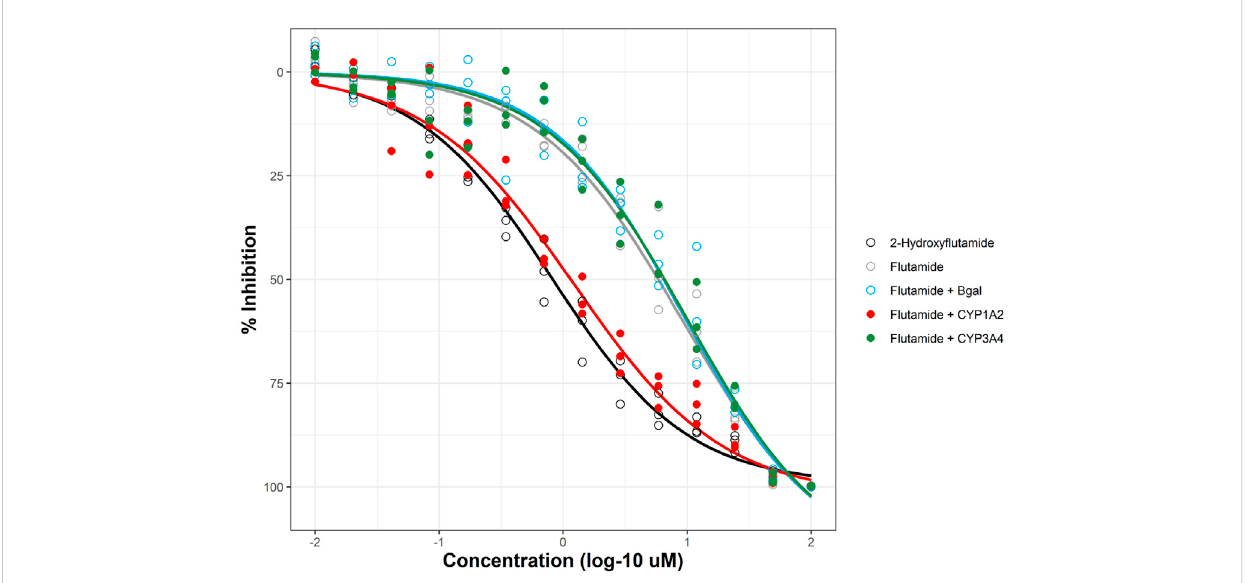
FIGURE 5 Metabolic retro fi t of AR2 assay. AR2 cells were transfected with mRNAs encoding beta-galactosidase (Bgal, blue), human CYP1A2 (red), CYP3A4 (green), or no RNA (black and grey) 6 h prior to co-treatment with 10 nM R1881 and either fl utamide or its anti-androgenic metabolite, 2- hydroxy fl utamide (black) at concentrations ranging from 10 nM to 100 µM for an additional 18 h. Responses are expressed as % inhibition (of maximal response). Concentration-response curves were fi t using tcpl_Lite. Data represent individual wells from three independent